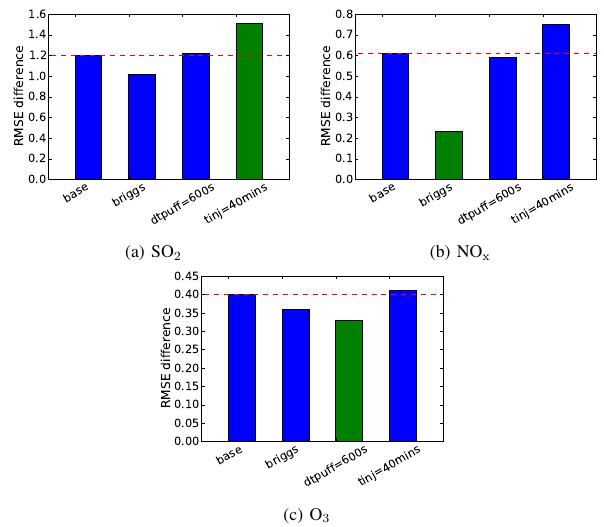
Fig. 13. Differences (Polair3D - plume-in-grid) in RMSE (µgm − 3 ), computed on all stations and six months for SO 2 , NO x and O 3 . (1) “base”: plume-in-grid with similarity theory, t inj =20 minutes and ∆ t puff =100 s , (2) “briggs”: base case with Briggs formulas instead of similarity theory, (3) base case with ∆ t puff =600s , (4) base case with t inj =40 minutes. Dotted line : base results. Green bars corre- spond to the highest sensitivity for each species.